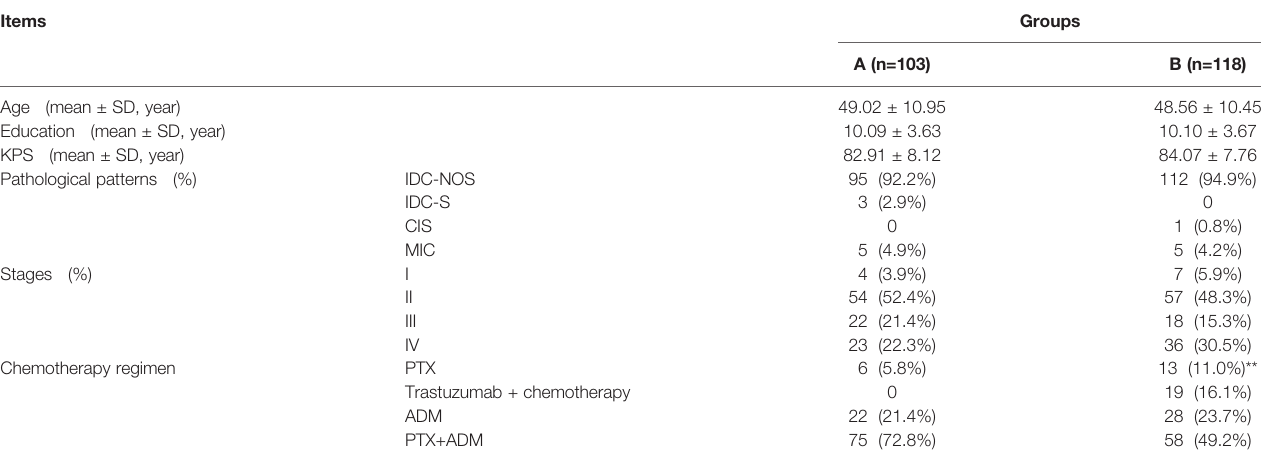
TABLE 1 | The basic clinical dates of breast cancer patients with HER2 − and HER2+. Items Groups